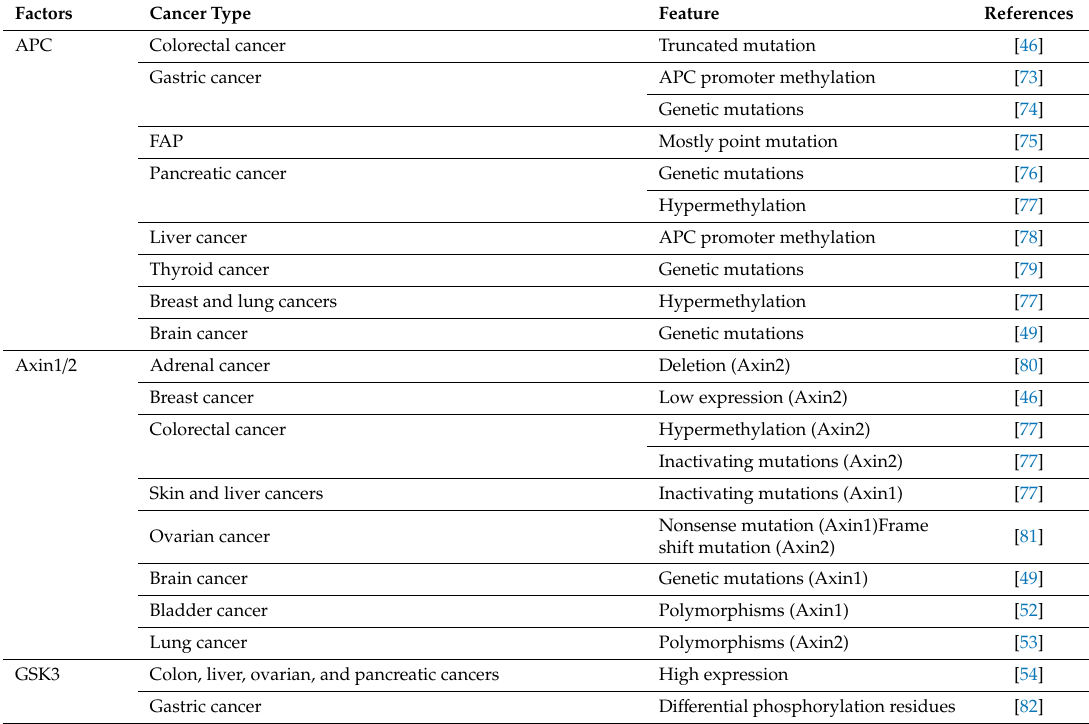
Table 1. Wnt signaling factors in various